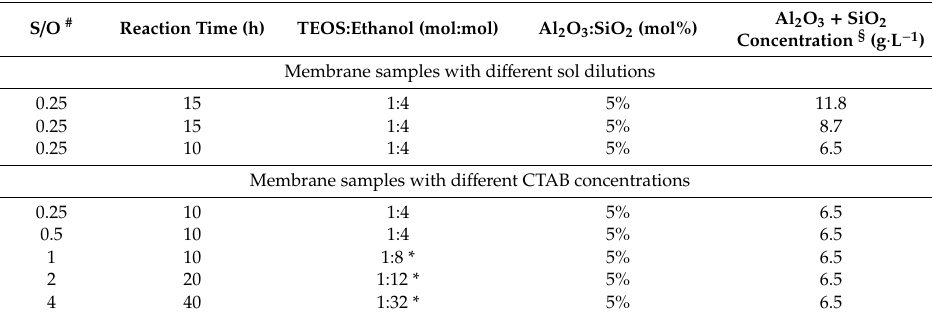
Table 1. Fabrication parameters of the membrane samples synthesized in this